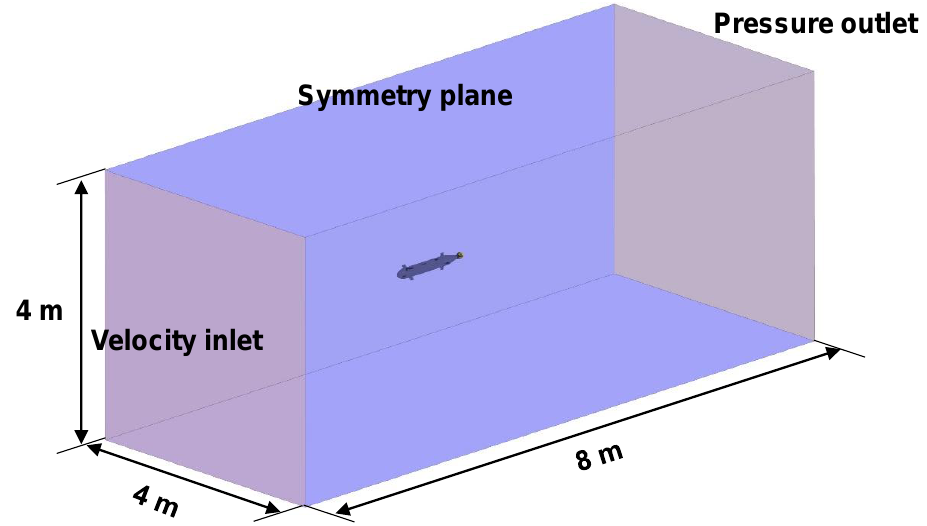
Figure 3. Specification of simulation domain and boundary condition